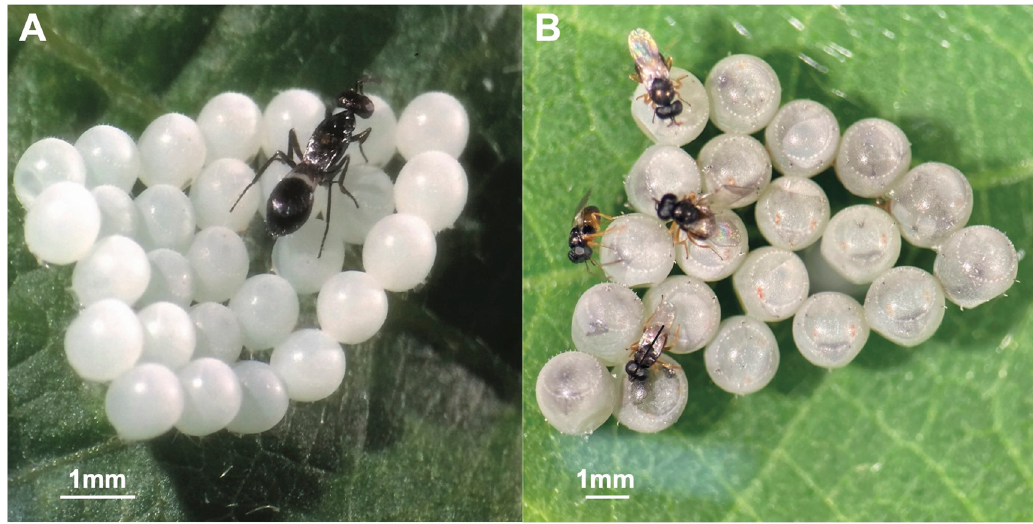
Figure 2. Anastatus bifasciatus ( A ) and Ooencyrtus telenomicida ( B ) observed on eggs of Halyomorpha halys . Table 2. Data on naturally laid egg masses of Halyomorpha halys collected from June to October 2020 from different locations in Greece.